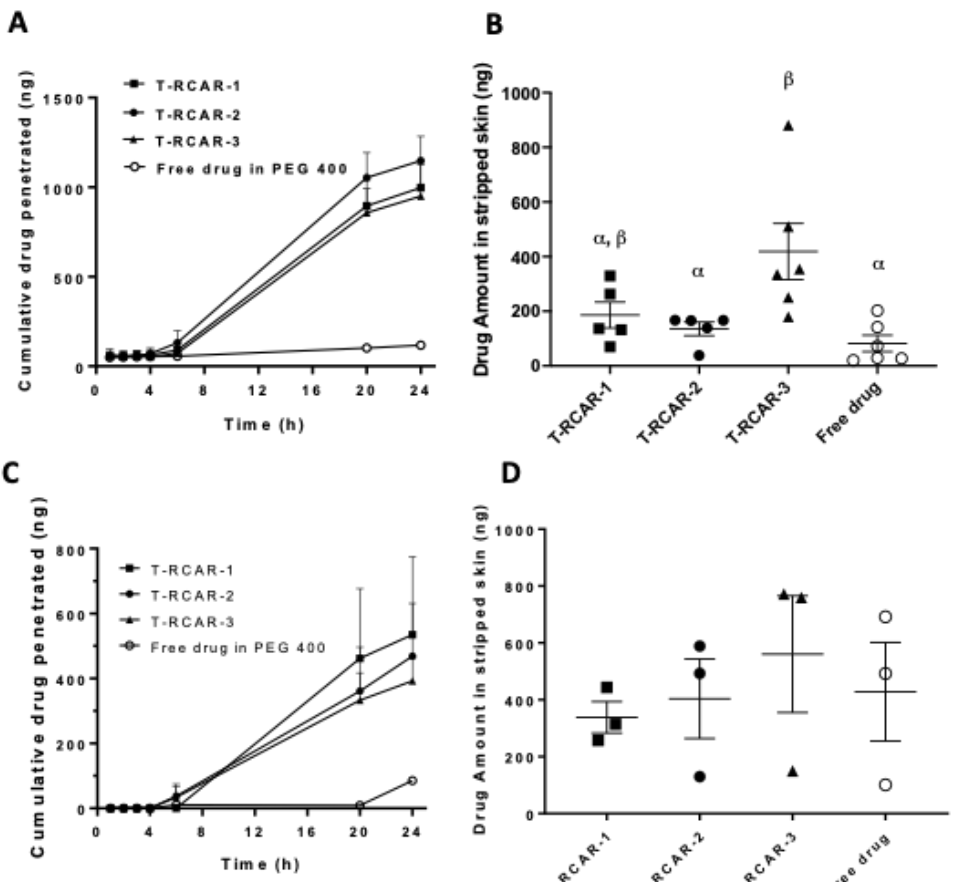
Figure 2. Ex vivo skin drug permeation profiles of T-RCARs using 40% PEG 400 in PBS or 4% BSA in PBS as receiver media. ( A ) Formulations containing 4 μg drug in 0.2 mL formulation solutions were loaded to the skin facing the donor compartments in the Franz diffusion cells. Data shown are cumulative R-carvedilol permeated into the receptor compartment as a function of time up to 24 h. The receiver compartment contains PBS containing 40% v/v of PEG400. Data are presented as mean ± SE (n = 5~6). ( B ) R-carvedilol levels in stripped skin (epidermal and dermal layers) 24 h after loading the drugs, determined via HPLC. Data are presented as mean ± SE (n = 5~6). ( C ) Cumulative R-carvedilol permeated into the receptor compartment as a function of time up to 24 h. The receiver compartment contains 4% BSA in PBS. Data are presented as mean ± SE (n = 3). ( D ) R-carvedilol levels in stripped skin (epidermal and dermal layers) 24 h after loading the drugs, determined via HPLC. Data are presented as mean ± SE (n = 3). An ANOVA followed by a Tukey–Kramer multiple comparisons test was used to assess statistical differences at p < 0.05, and differences denoted by different Greek